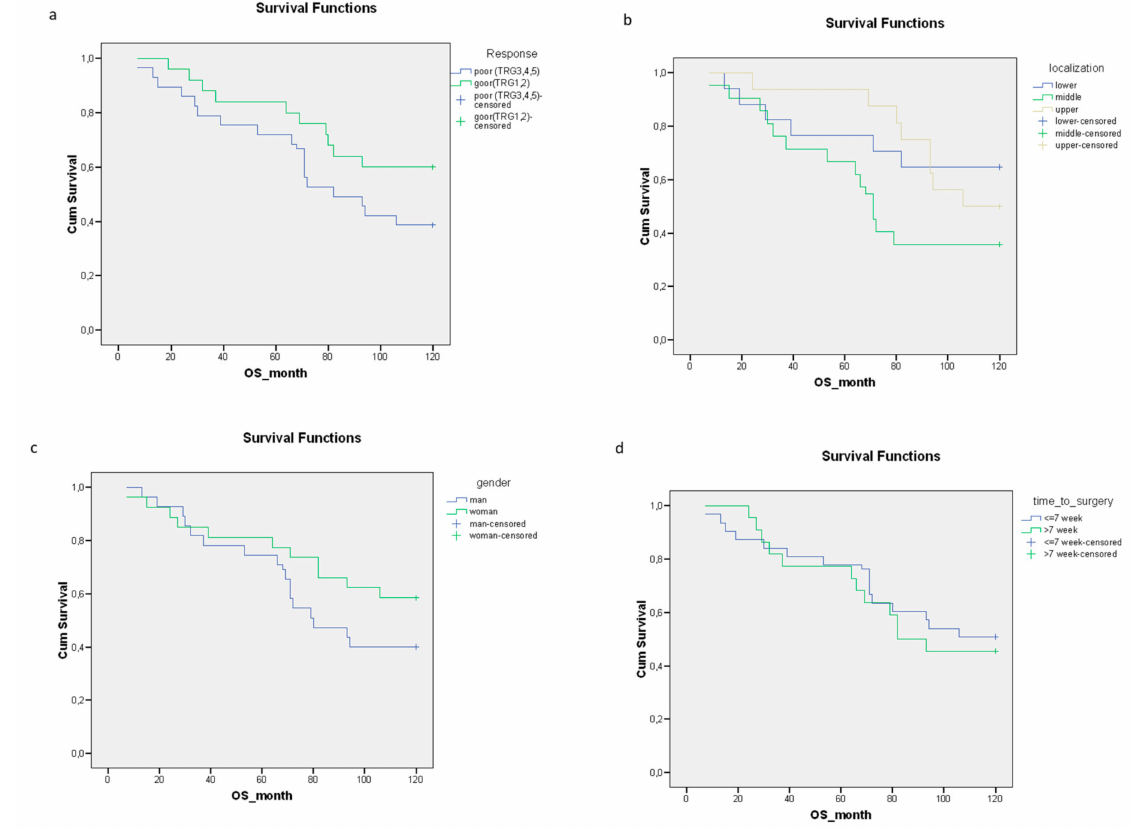
Figure 2. The relationships between clinical parameters including the ( a ) histopathological response ( p = 0.029), ( b ) tumor localization ( p = 0.015), ( c ) gender ( p = 0.057) ( d ) time to surgery ( p = 0.568) and 10-year OS rate. The effects of the clinical parameters on the overall survival were demonstrated using Kaplan–Meier curves and the level of significance was determined using the log-rank test. Probability ( p ) values < 0.05 were considered statistically